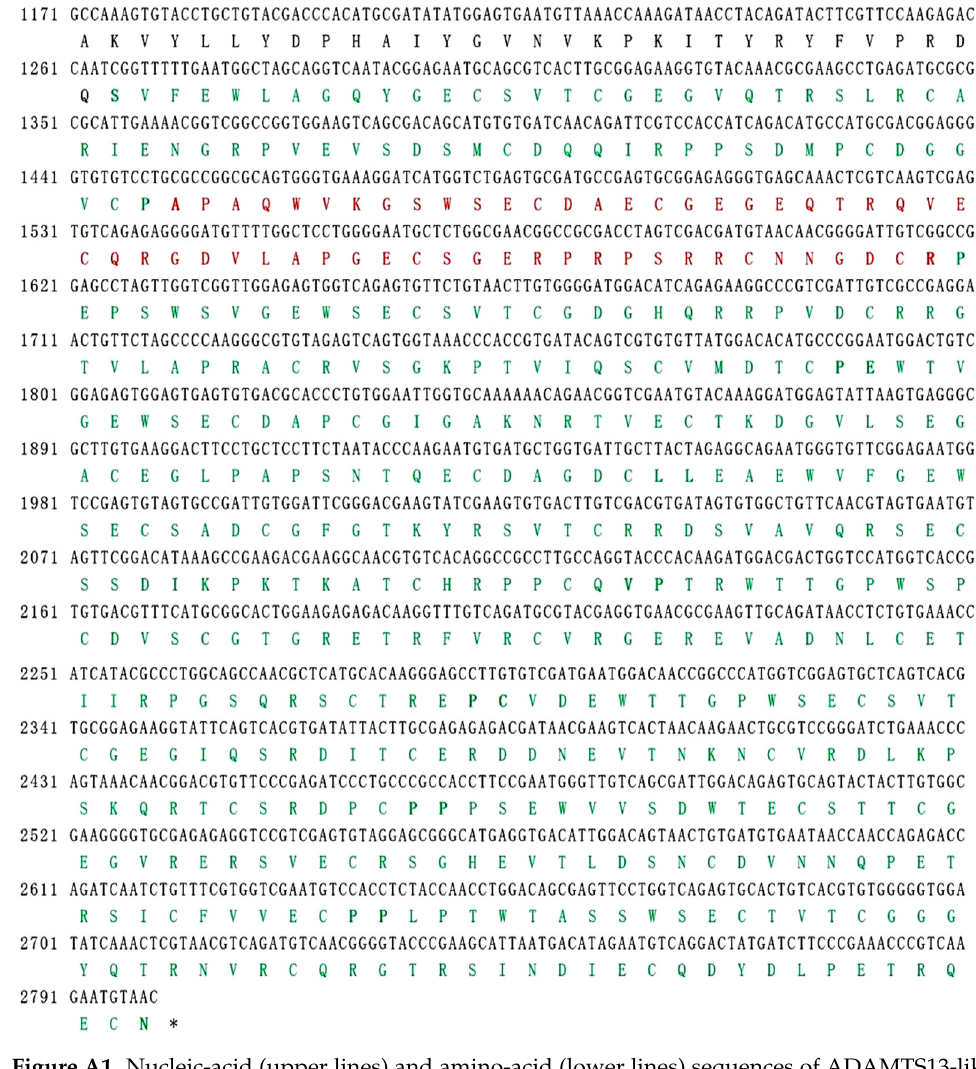
Figure A1. Nucleic-acid (upper lines) and amino-acid (lower lines) sequences of ADAMTS13-like from A. japonicus . Green color indicates the 10 TSP1 domains, except the third TSP1 domain, which is marked with red.